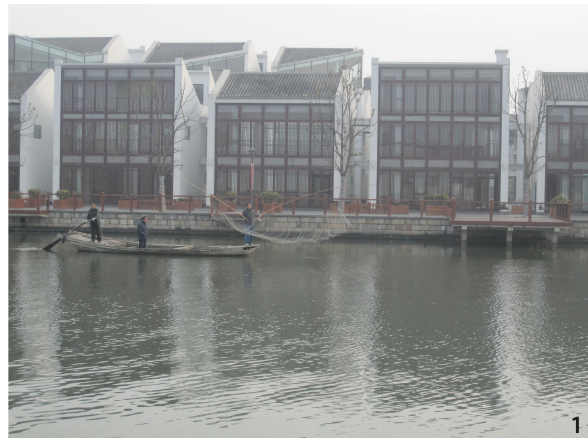
Figure 1 Shangduli’s scale and texture are a continuation of the inti- macy and atmosphere of the old city, in a modern way without imitat- ing or falsifying history (Source: the